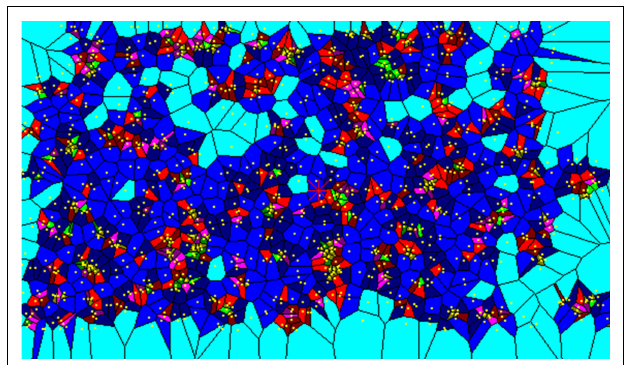
FIGURE 1 | Voronoi polygons drawn from tangential maps of MAP2- positive apical dendrites. Each polygon area delineates the territory of the map which is closer to the point than to any other point of the map. Yellow dots correspond to apical dendrites. Colors of polygons are related to their size (green the smallest, light and dark blue the largest). The clusterization of dendrites is